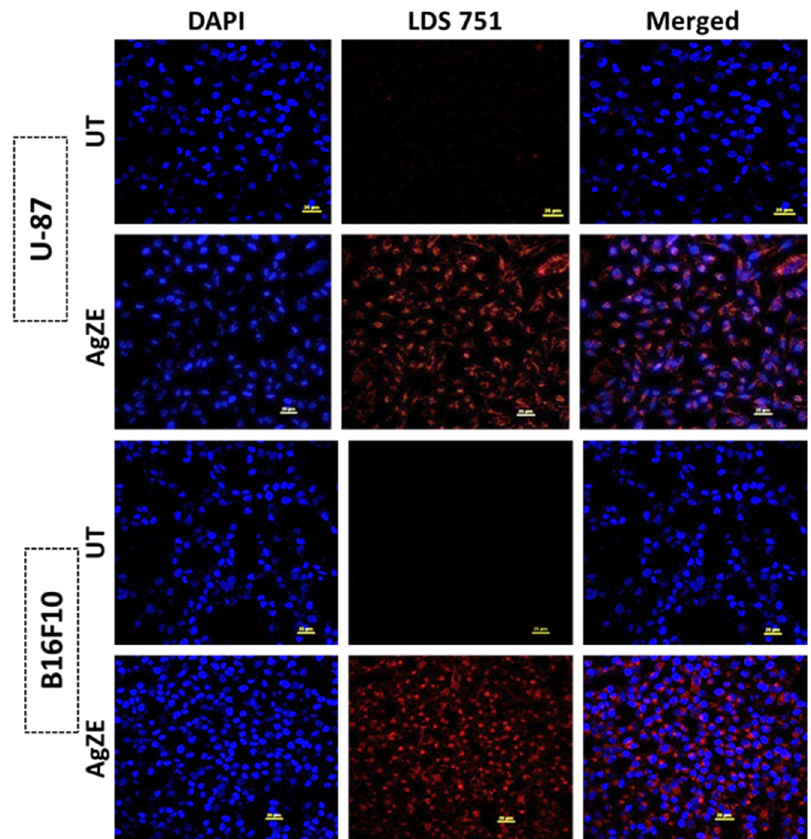
Figure 8. In vitro cellular uptake studies of AgZE in U-87 and B16F10 cancer cells using confocal microscopy (Row I: U-87 untreated; Row II: U-87 AgZE treated; Row III: B16F10 untreated; Row IV: B16F10 AgZE treated; Column I: Dapi; Column II: LDS 751; and Column III: Merged). The red fluorescence from AgZE-treated cells is collected under the LDS 751 channel of the confocal microscope using a 60× objective.